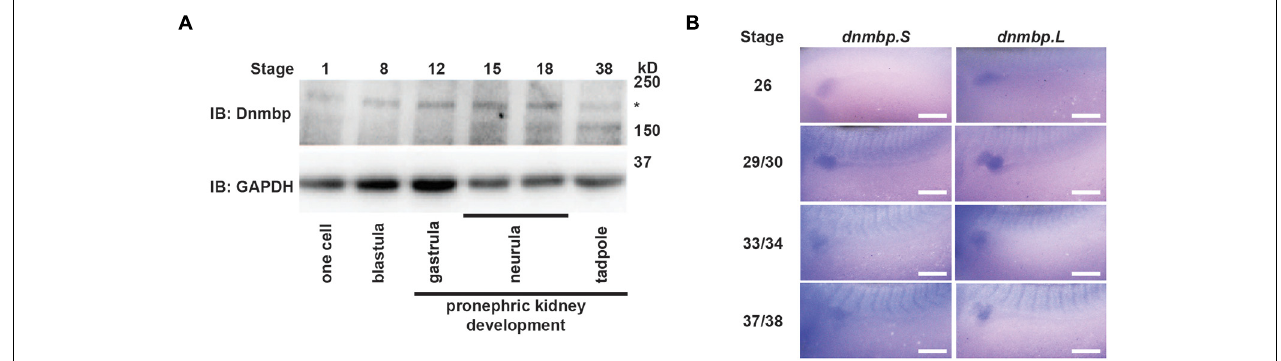
FIGURE 2 | Knockdown of Dnmbp results in reduced kidney tubulogenesis. (A) Western blot showing the efficiency of two different MOs targeting Dnmbp. Single cell embryos were injected with 40ng of Dnmbp MO 1, Dnmbp MO 2 or Standard MO. One embryo equivalent per lane was loaded on to the SDS-PAGE gel. (B) Schematic of the Xenopus pronephros showing the proximal, distal and connecting tubule regions. (C) Unilateral injection of 20ng Dnmbp MO 1 into blastomere V2 at the 8-cell stage leads to defects in kidney tubulogenesis in comparison to embryos injected with Standard MO. Antibody 3G8 used to label the lumen of the proximal tubule, antibody 4A6 used to label the distal and connecting tubules. memRFP used as an injection tracer. White bar indicates 200 µ m. ∗ indicates injected side of embryo. (D) Knockdown of Dnmbp leads to reduced expression of differentiated kidney tubule markers in comparison to embryos injected with Standard MO. n = number of embryos across 3 replications. Error bars represent Standard error. ∗ Significantly different from control, p < 0.05.